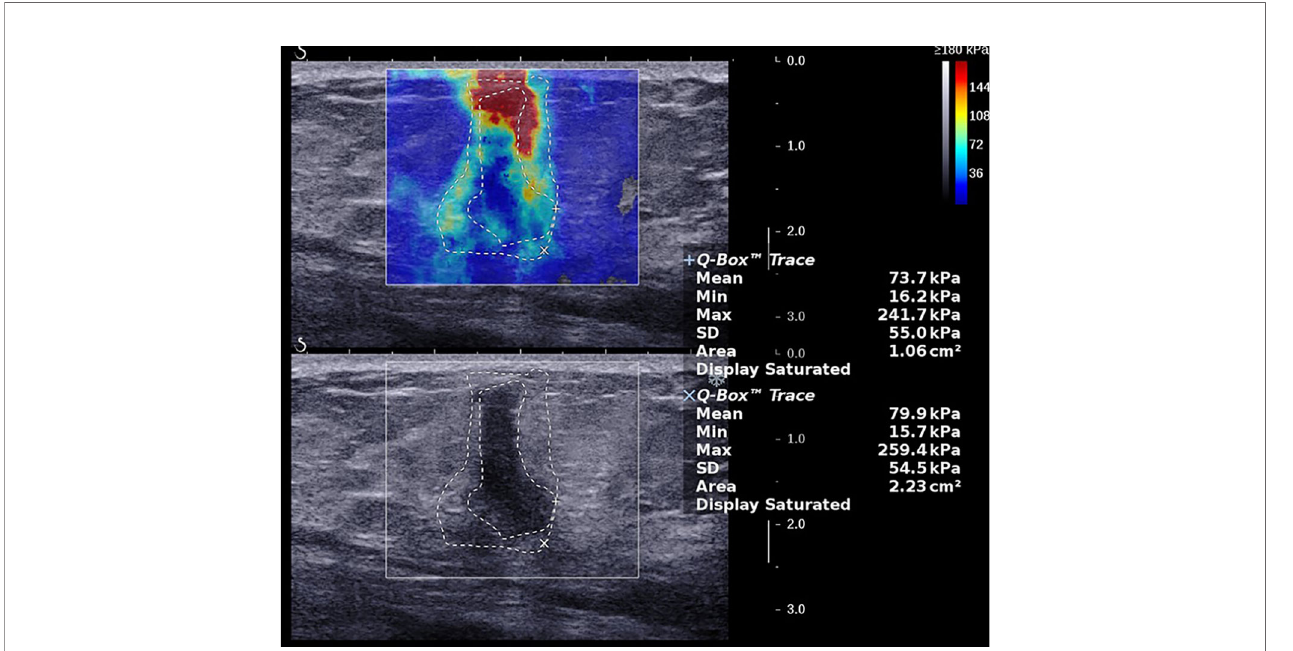
FIGURE 2 | A 57-year-old female with a 15.0-mm lesion in the left breast. The SWE parameter values of the cancer were as follows: E max , 261.5 kPa; E mean , 82.4 kPa; SD, 54.2 kPa; AR, 1.95. The lesion was invasive ductal carcinoma with the histological grade II, showing negative lymphovascular invasion and negative axillary lymph node status, ER - and PR - , HER2 + , and high expression of Ki-67, 15%.